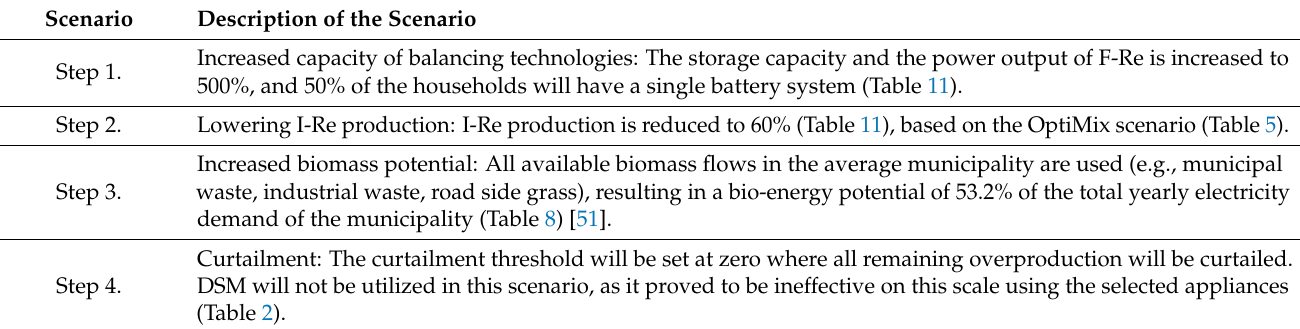
Table 10. The Optimization